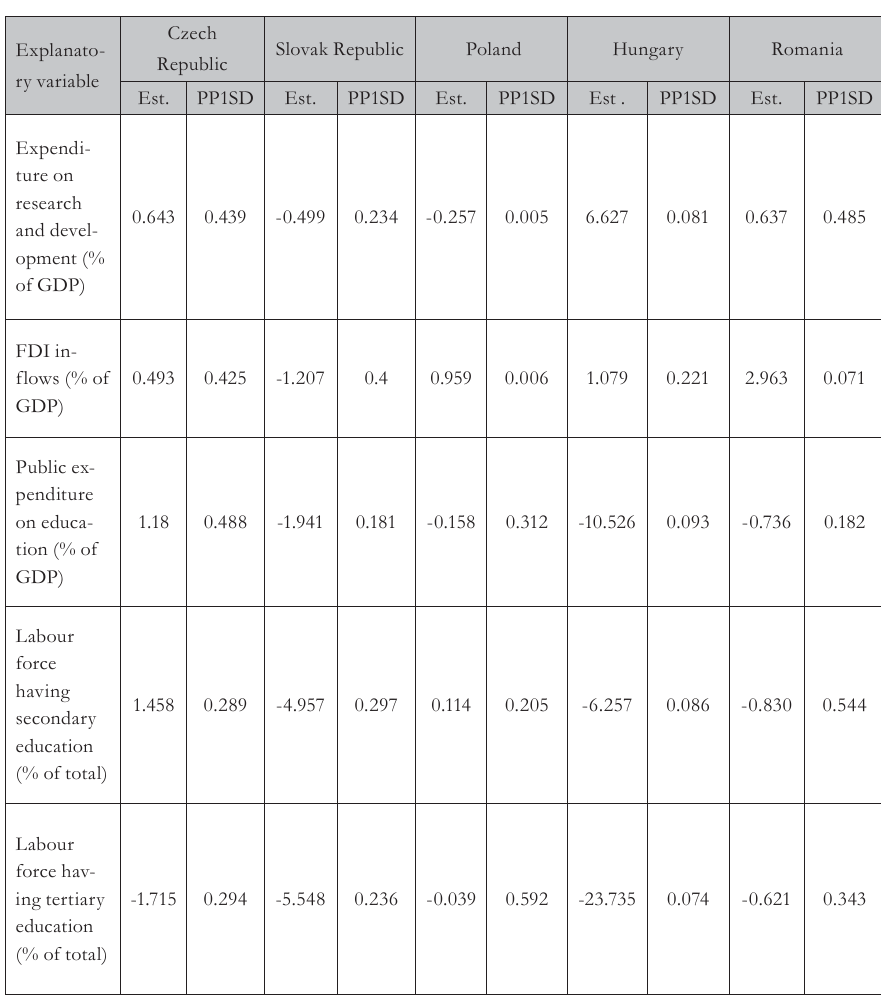
Tab. 1- �arginal posterior estimates for generalized Bayesian ridge regress. Source: own esti-